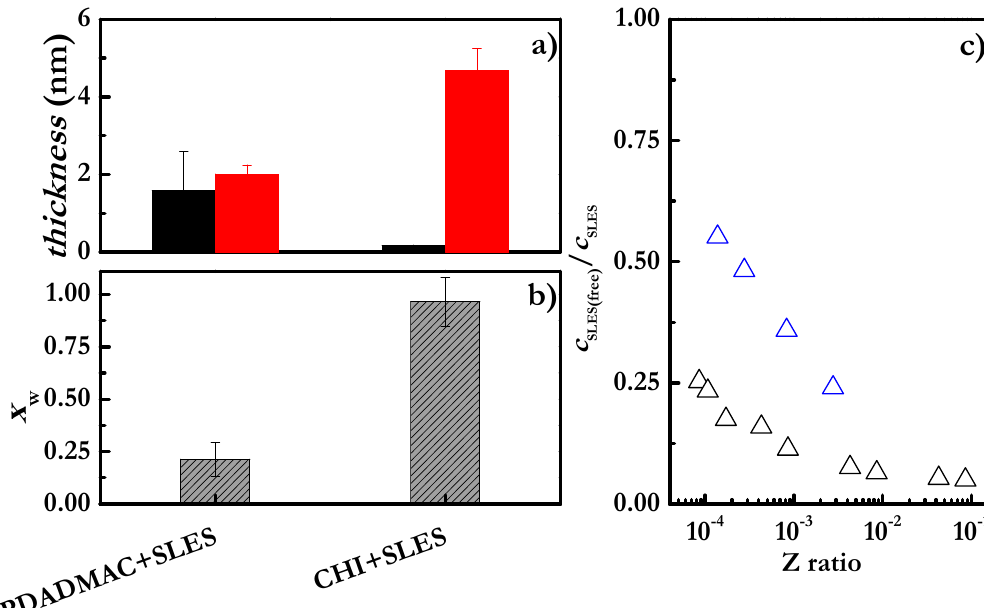
Figure 8. Effect of the polymer’s nature on: ( a ) The optical ( ■ ) and hydrodynamic ( ■ ) thicknesses of layers formed by the deposition of polyelectrolyte–SLES mixtures, with polymer concentration of 2 g/L, SLES concentration 0.1 mM and NaCl concentration of 100 mM. Note that the reported thicknesses in the three panels correspond to those obtained after the rinsing of the adsorbed layers with aqueous solutions with the same NaCl concentration as that contained in the solutions used for the layer deposition. ( b ) The water content of layers formed by the deposition of polyelectrolyte–SLES mixtures, with polymer concentration of 2 g/L, SLES concentration 0.1 mM and NaCl concentration of 100 mM. ( c ) Z ratio dependences of the ratio between the concentration of free SLES molecules remaining in the solution, as was obtained from potentiometric titration ( c SLES(free) ), and the total SLES concentration ( c SLES ) for CHI-SLES ( Δ ) and PDADMAC-SLES ( Δ ) mixtures. Note that the concentration of NaCl was fixed at 100 mM.